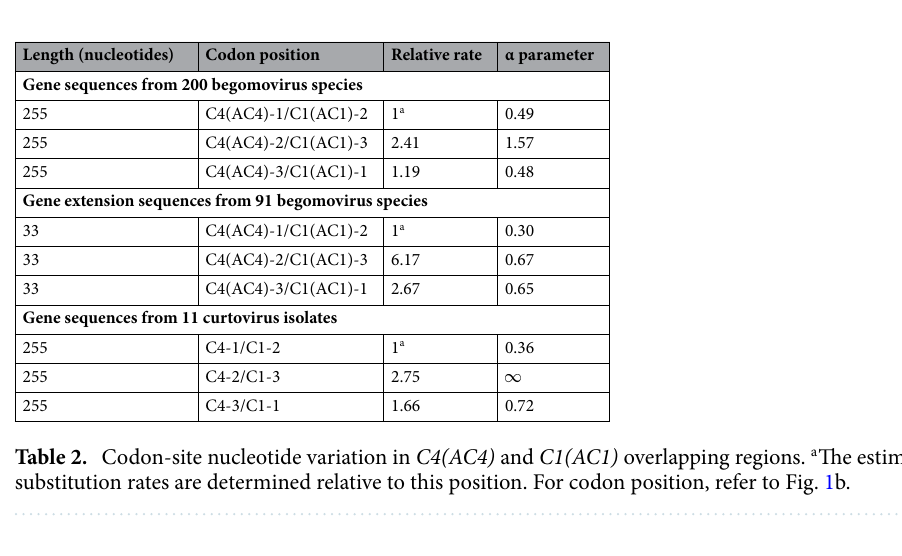
rate compared to the other codon positions, but had an α-value of 0.67. An α ≤ 1 indicates that most of the codon positions have very low substitution rates with some sites being hotspots with very high substitution rates 50 . Selective pressure on begomoviruses from tomato from native and exotic locations. The movement of crops around the world results in plants encountering new pathogens. This ‘new encounter phe- nomenon’ occurs when a crop has been introduced into a new geographical region and pests and/or pathogens that evolved with native host species in the introduced region infect and cause disease in the newly introduced exotic crop species 51 . In this study, the native range of a plant is defined as the geographic region in which the species originated as well as the surrounding area where indigenous people may have moved and domesticated the species. Exotic is defined as regions far enough outside the native range of the plant that indigenous people were not likely involved in moving the species, rather it was introduced by movement over long distances. When we tallied whether the begomovirus isolates of > 420 species originated from a host plant within its native range or outside of its native range (exotic) we found that 52.5% of the Begomovirus species were isolated from a host plant outside of its native range (Supplementary Table S3). A large number of Begomovirus species (112 of 420) have been isolated from tomato with approximately 70% of the species being isolated from tomato grown outside of western South America and Central America, the